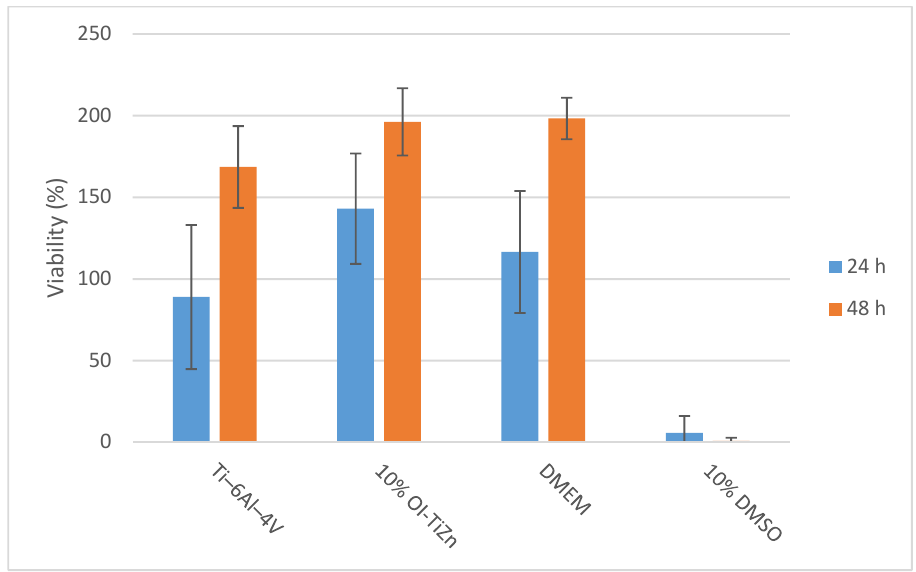
Figure 13. Viability analysis of 4T1 cells in terms of their metabolic activity after incubation of 24 h and 48 h in extracts of the tested materials.